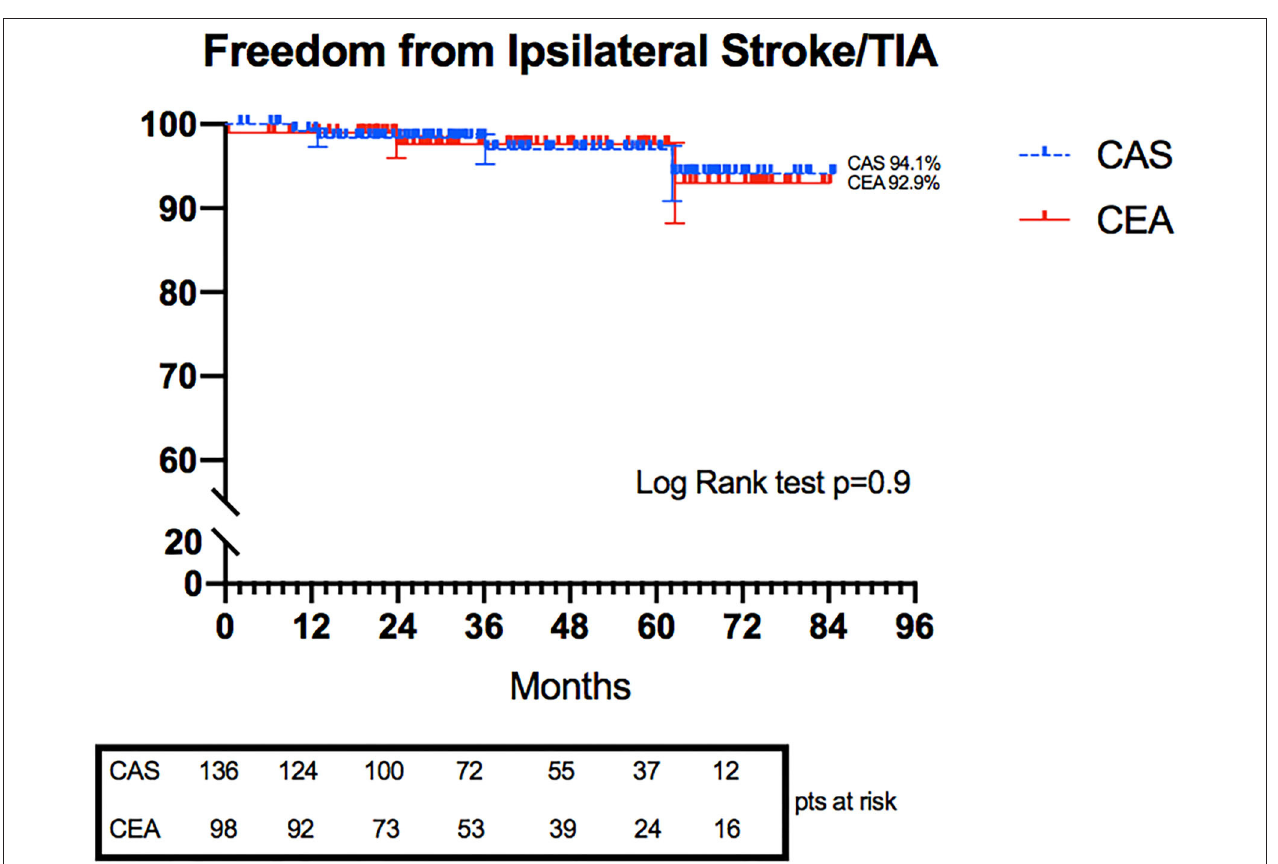
FIGURE 2 | Kaplan–Meier curves representing freedom from Ipsilateral Stroke/TIA in CAS and CEA groups.